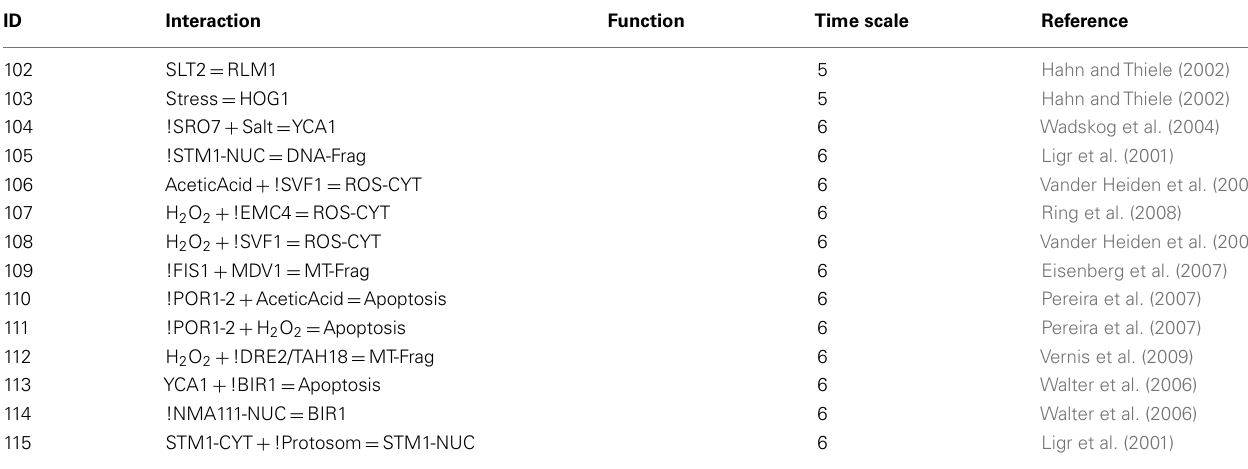
Table 4 | Predicted states of relevant species at steady state.